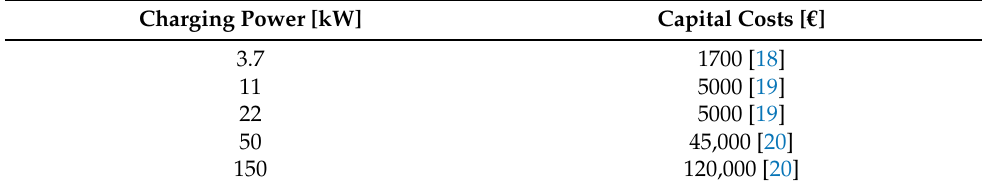
Table 1. Capital costs per charging point and installed power.